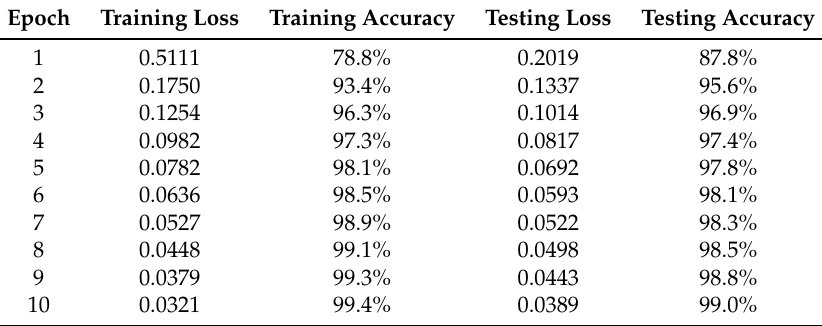
Table 2. Experimental results of model training and